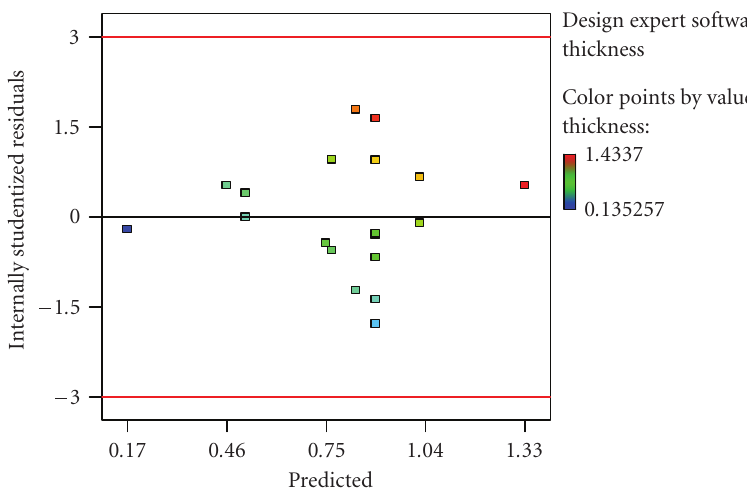
Figure 6.2 . Residual versus predicted response for chip thickness